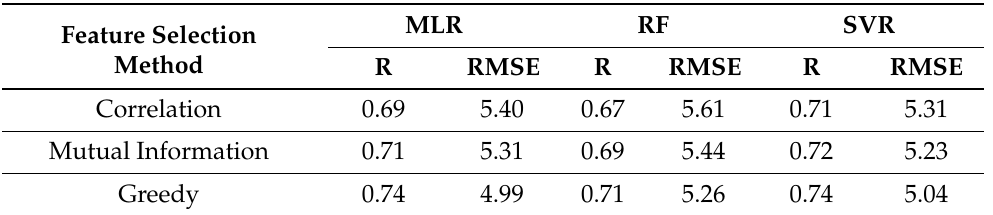
Table 6. Performance Metrics of Models for Exercise